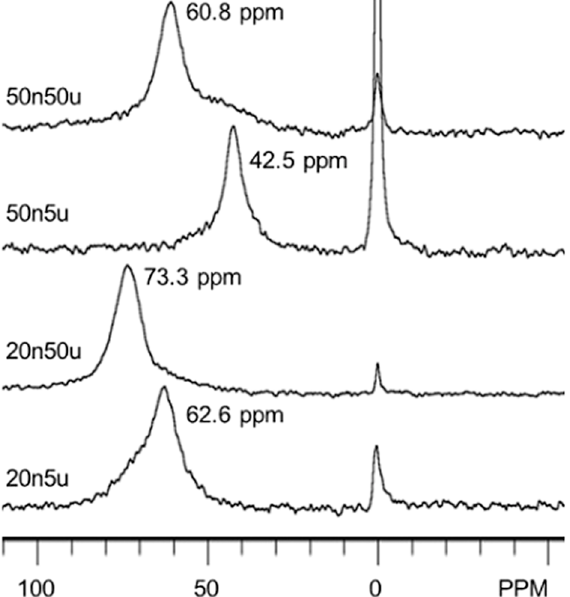
Figure 15. HP 129 Xe NMR spectra of various mesoporous silicon sponges acquired at 300 K. The labels indicate pore sizes determined by SEM images (20 nm and 50 nm, respectively) and the particle sizes (5 μ m and > 50 μ m, respectively). Reprinted with permission from reference [143]. Copyright 2017 Journal of Materials Research .